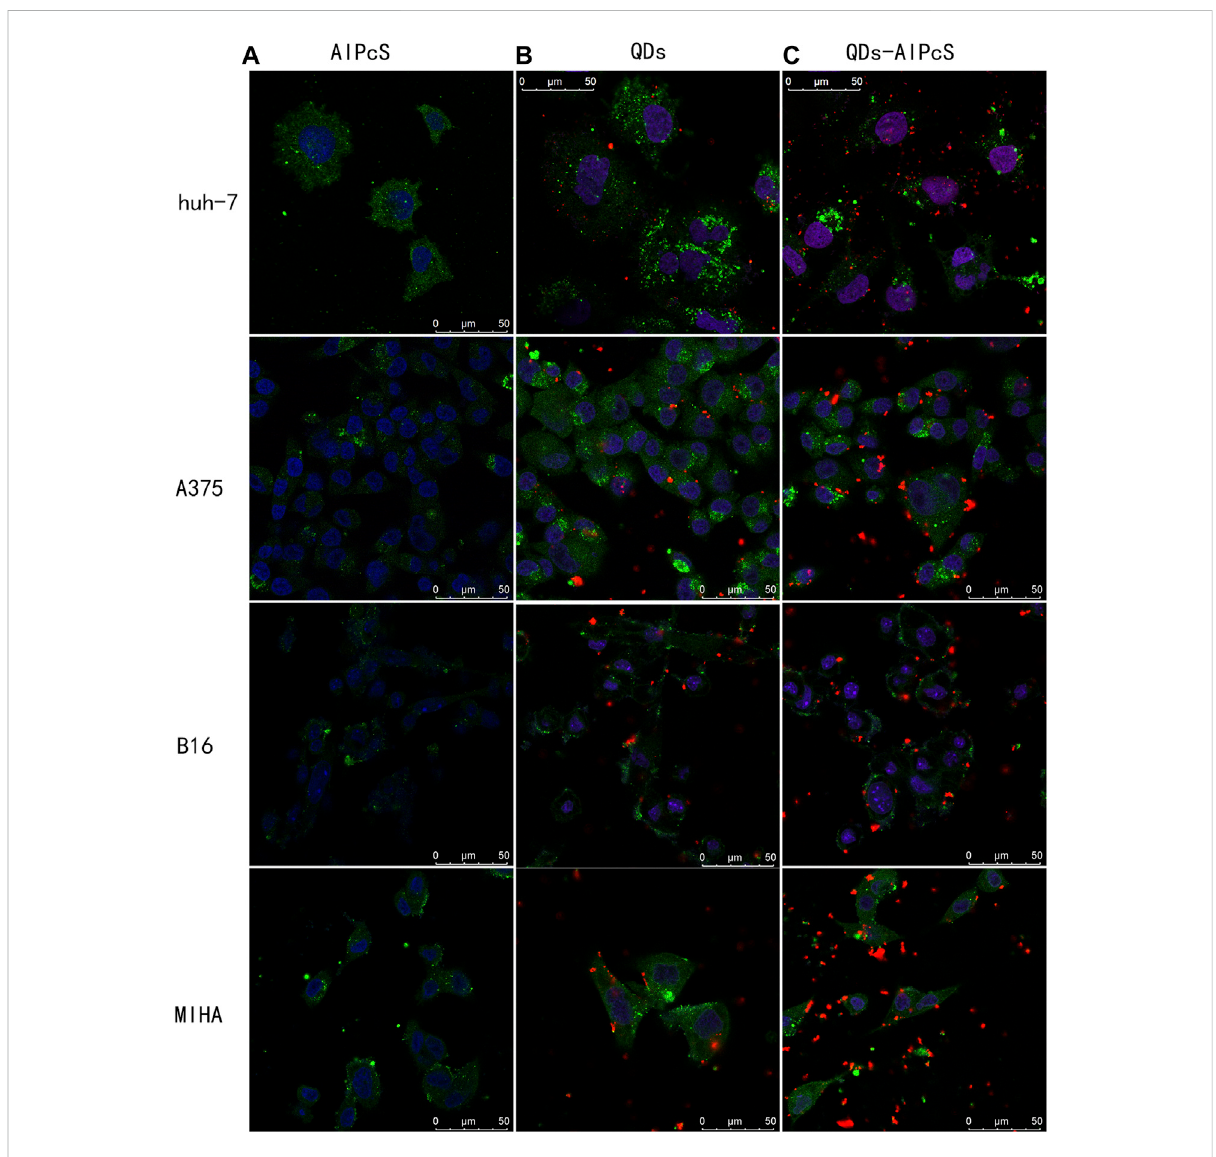
Confocal laser scanning microscopy image of four cell types incubated with three different materials for 2 h. The cytoskeleton was dyed green byFITC,and thenucleus wasdyedbluebyDAPI.The cellswereincubated withtheQD (0.4 uM)solution (B) andQD-AlPcS(0.4 uM – 20 uM)solution (C) were excited by 405 nm laser light and exhibited red fl uorescence in the picture. Cells incubated with free AlPcS (20 uM) solution (A) were irradiated with 638 nm laser light. Scale bar is 50